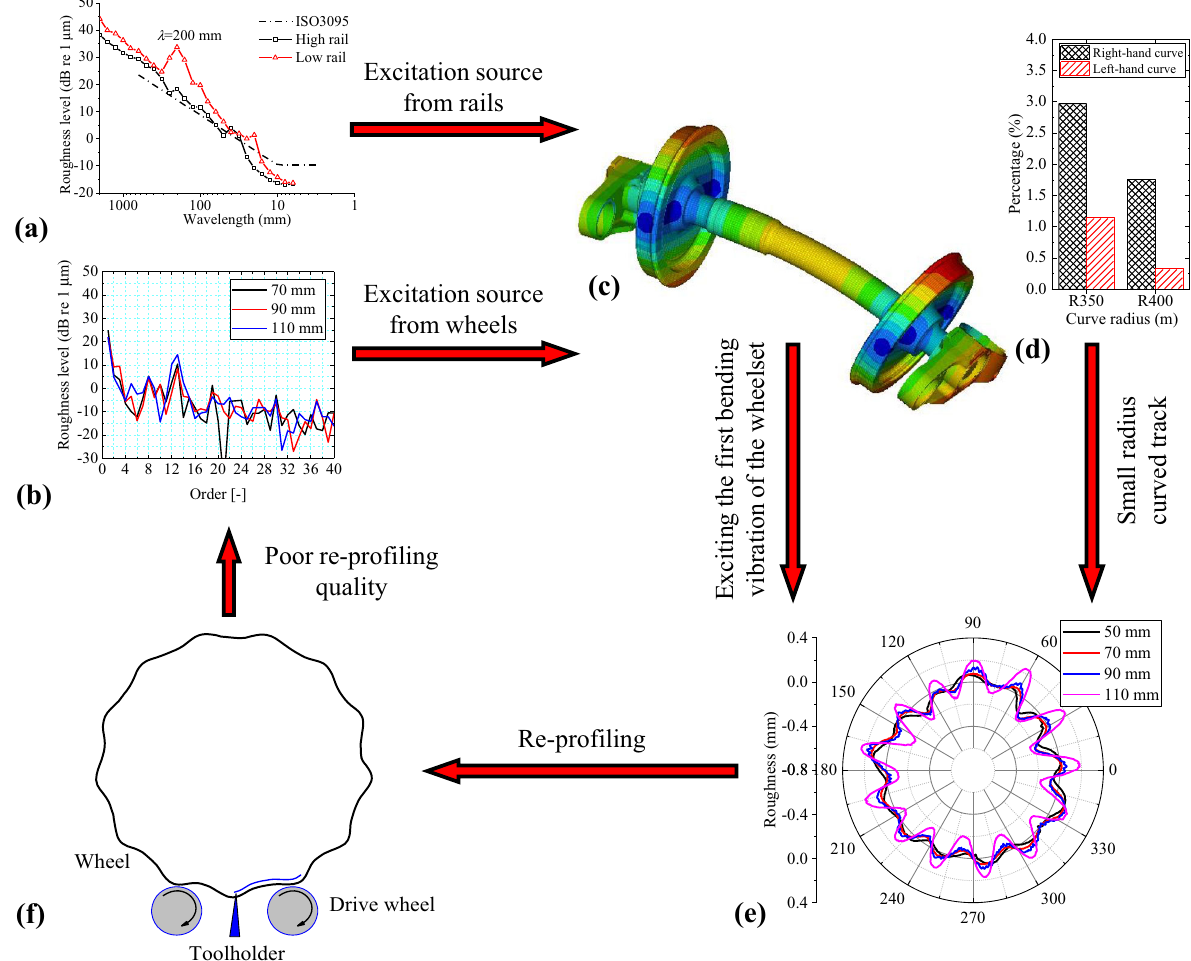
Fig. 16 Formation process of high-order polygonal wear of metro train wheels [16]: a rail corrugation on the low rail of sharp curves; b residual high-order polygonal wear after wheel re-profiling; c the first bending mode of the wheelset; d proportion of sharp curves; e serious high-order polygonal wear; and f wheel re-profiling with underfloor wheel